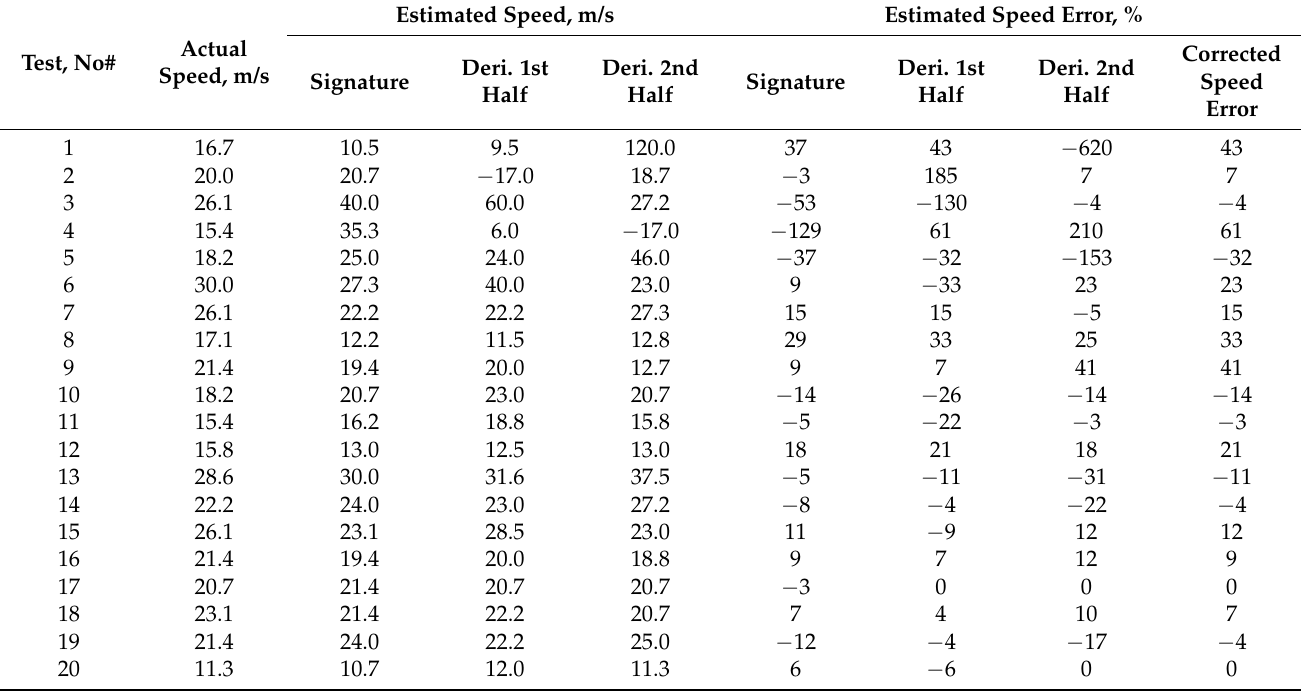
Table 3. Estimated speed correction by signal